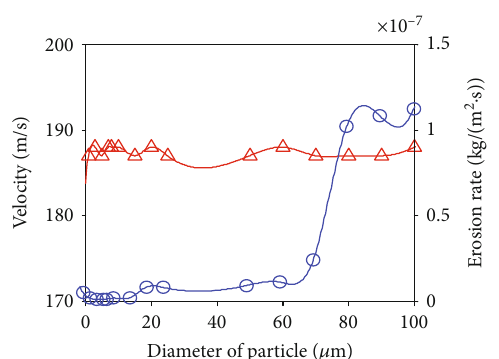
Figure 15: The relation curves among oil velocity, erosion rate, and particle ’ s diameter.